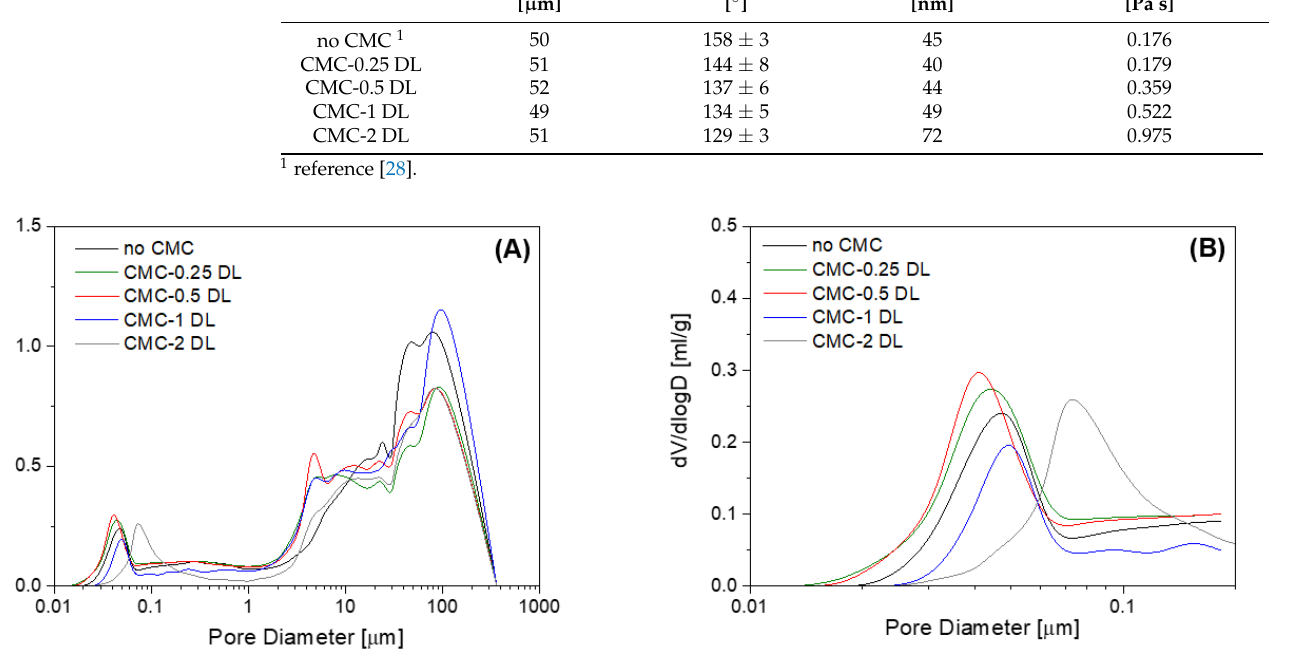
Figure 3. Pore size distribution obtained via the mercury intrusion porosimetry technique ( A ), enlargement of the microporous region ( B ).